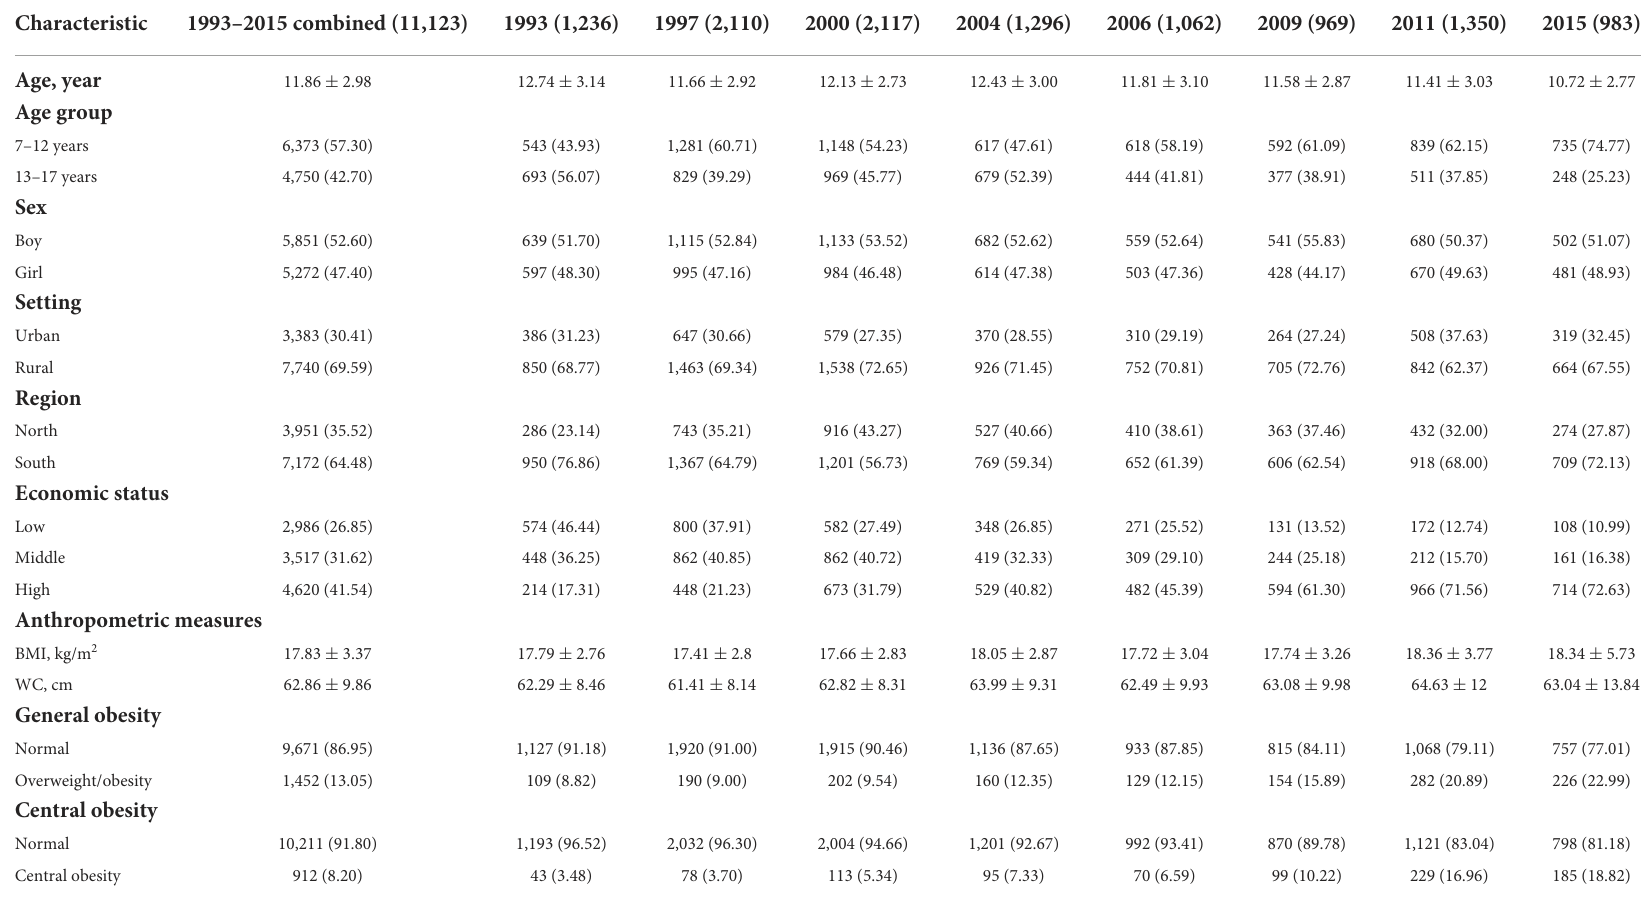
TABLE 2 Characteristics of included children in CHNS